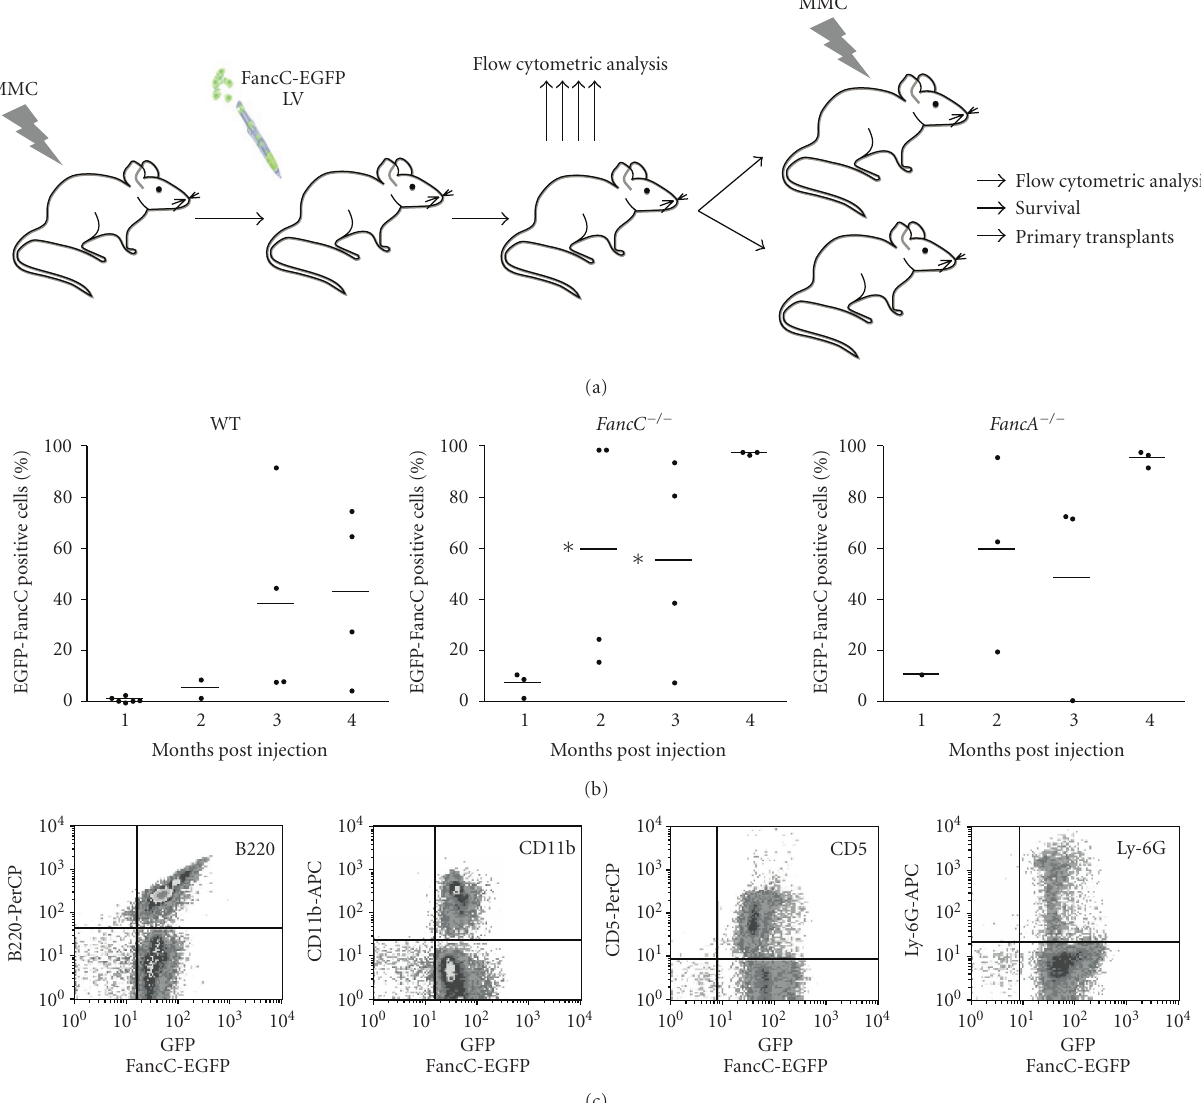
Figure 6: Corrective potential of intrafemoral gene transfer into FA mice with BM aplasia. (a) Illustration of the experimental protocol used to determine the corrective potential of intrafemoral LV-mediated gene transfer into aplastic BM. Wild type (WT), FancC − / − , and FancA − / − mice were preconditioned with MMC five days prior to intrafemoral injection of recombinant FancC-EGFP lentiviral particles. At 7 weeks following IF injections, each group of mice was divided where half of the mice were treated with MMC for 15 weeks (weakly s.c. injection of 0.3mg/kg). (b) Transgene expression was monitored each month for four months: FancC-EGFP transgene expression in peripheral blood cells of preconditioned IF-injected wild type (WT), FancC − / − , and FancA − / − mice. Each dot represents the FancC-EGFP expression of an individual IF-injected mouse. Horizontal line: mean value. ∗ P < . 05. (c) Representative cytometric profiles of FancC-EGFP expression in peripheral blood cell lineages from FancC − / − preconditioned IF-injected mice at four months following in vivo gene